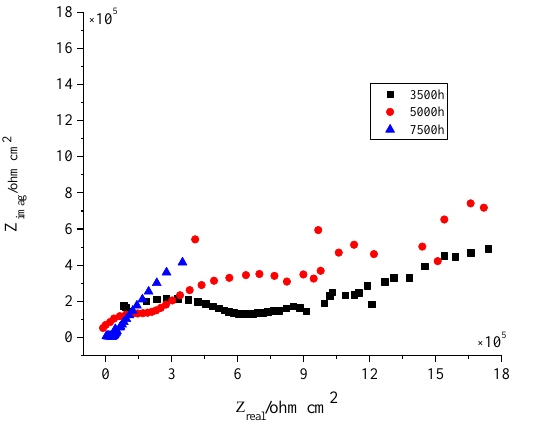
Figure 7. Nyquist charts of the thermal-spray zinc coating after being salt sprayed for 0–2000 h.